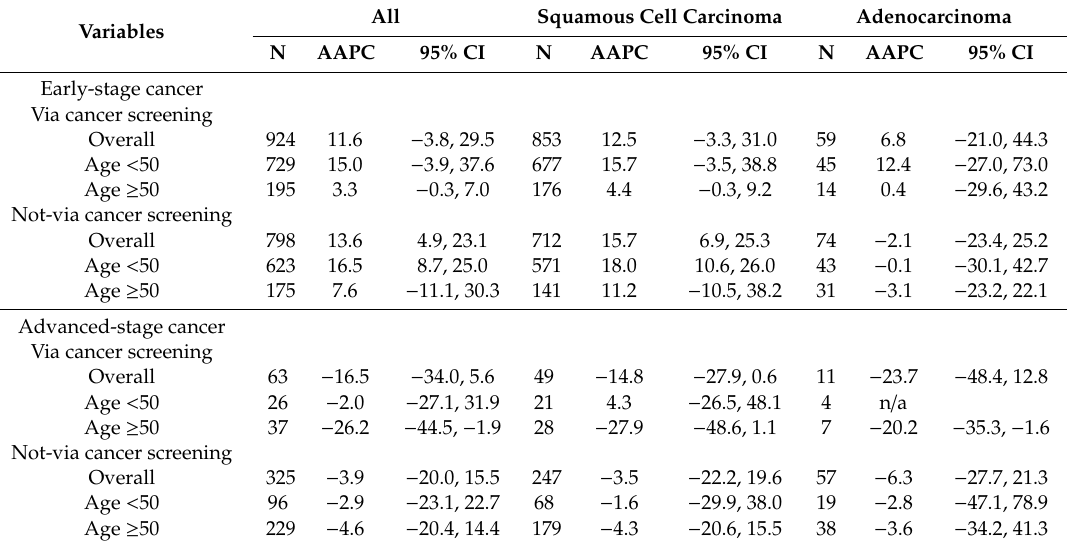
Table 3. Age-specific average annual percent change further stratified by cancer stage and screening